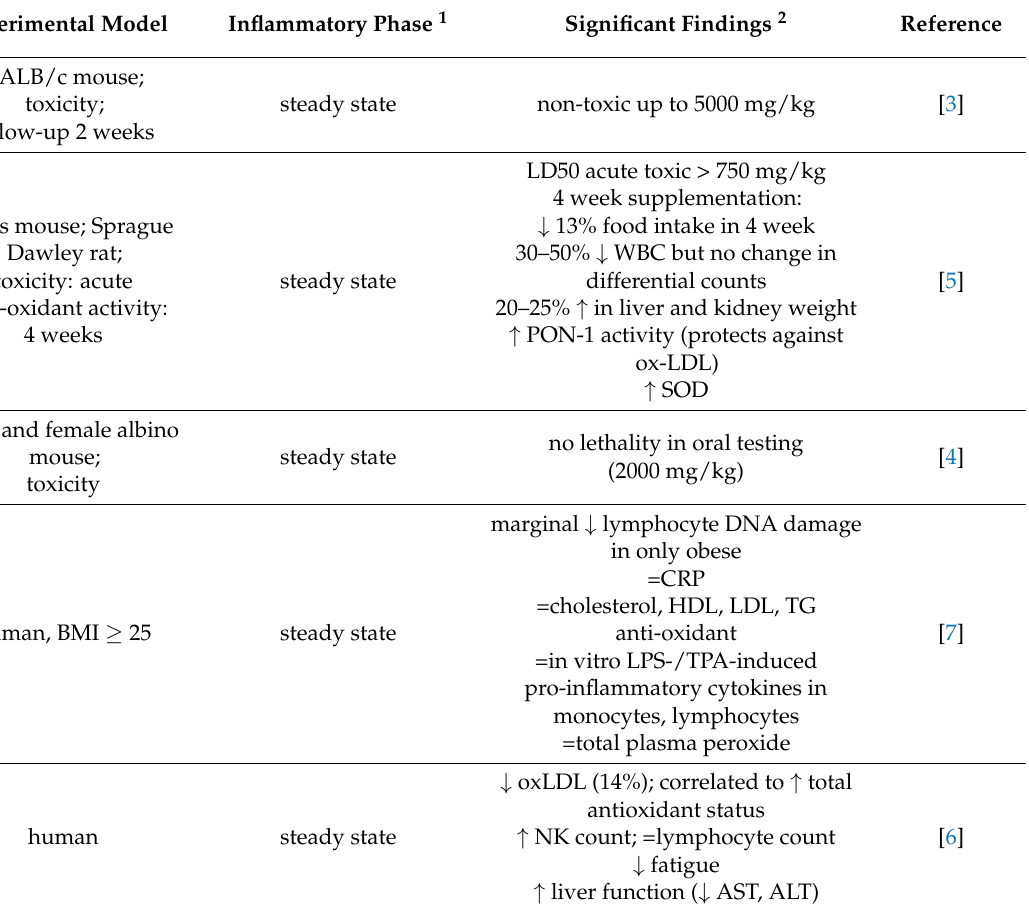
Table A1. Effects of oral supplementation of whole brown seaweeds or crude extracts on inflammation-related